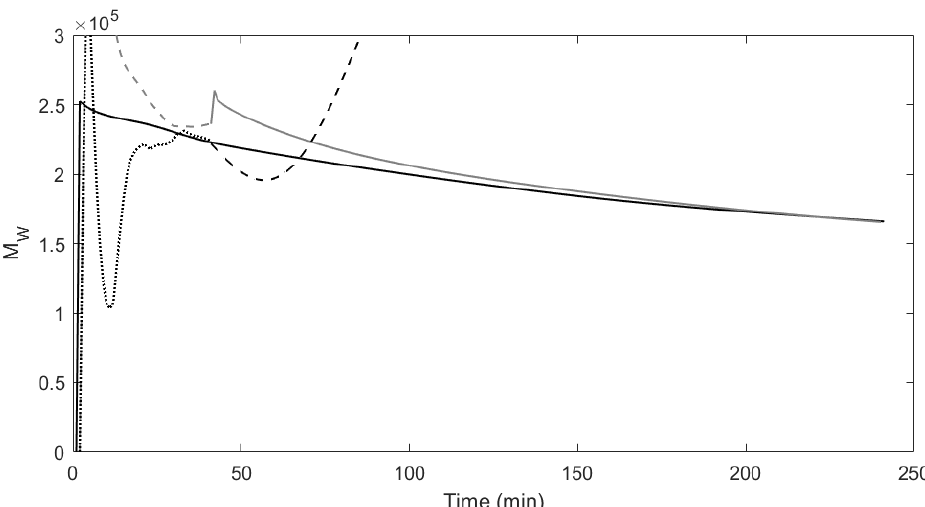
Figure 3. The weight average molecular weight predictions from both models with every tenth quality measurement retained and 30% missing output data. The dashed grey lines represent estimates made by the Luenberger observer until the 40th minute and the solid grey line shows the predictions from the proposed approach in comparison to the process, represented by the solid black line. The dotted and dashed black lines show the estimates made by the Luenberger observer and traditional subspace identification using linear interpolation, respectively.